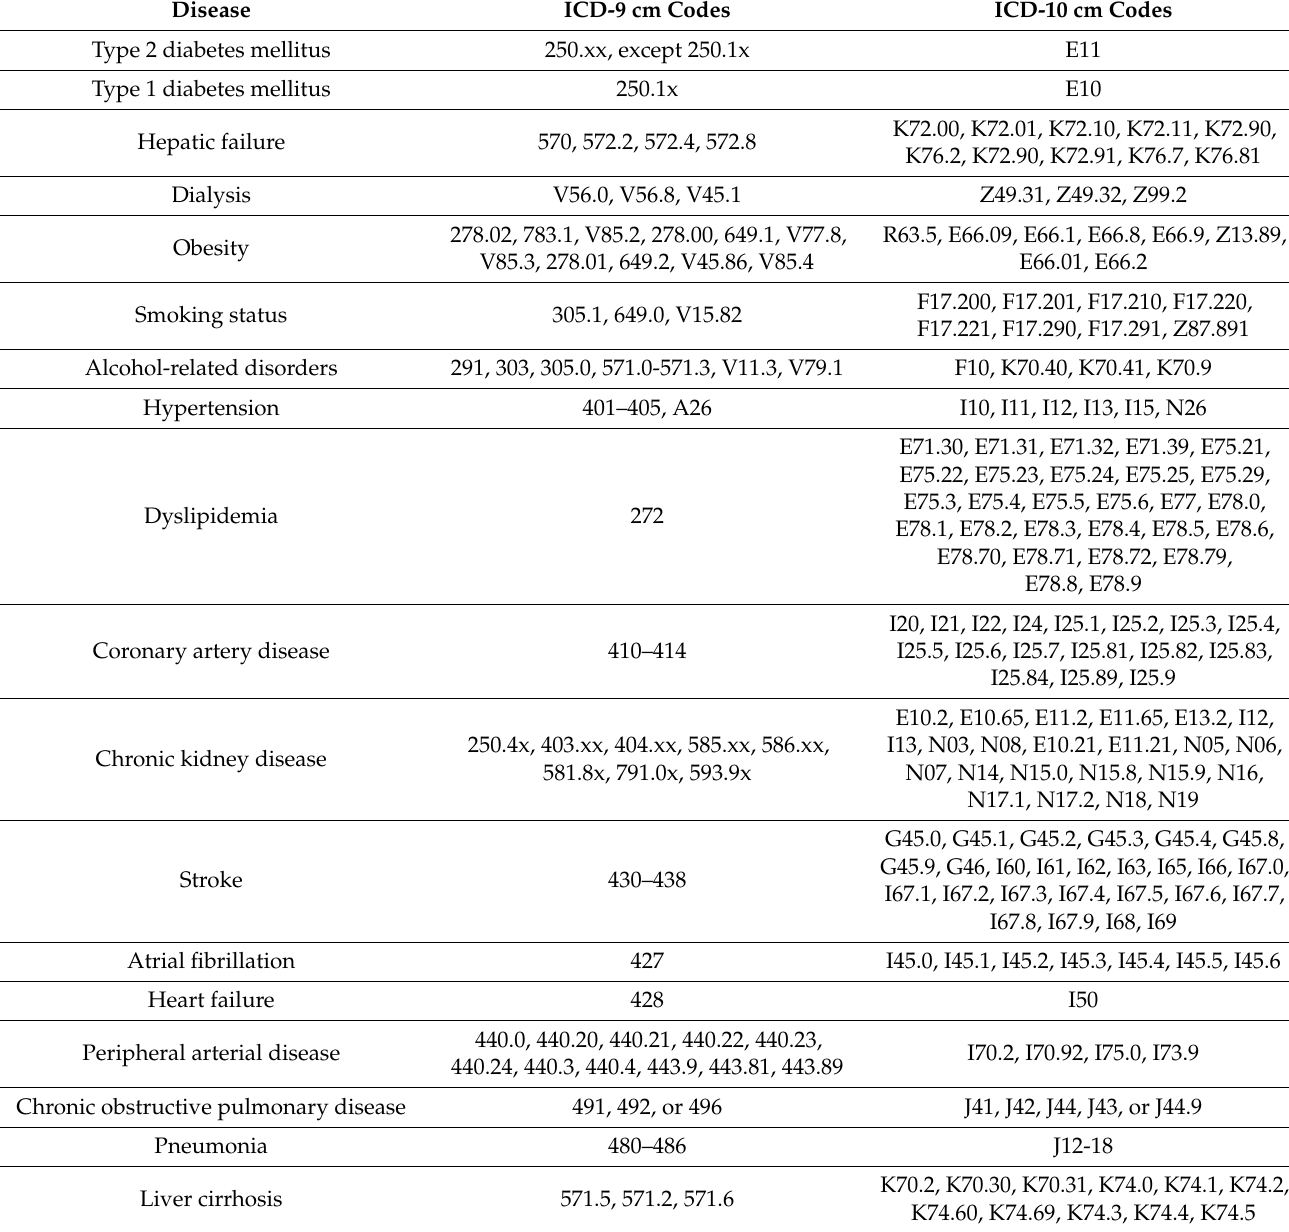
Table 1. Diseases and related ICD-9-CM, ICD-10 cm